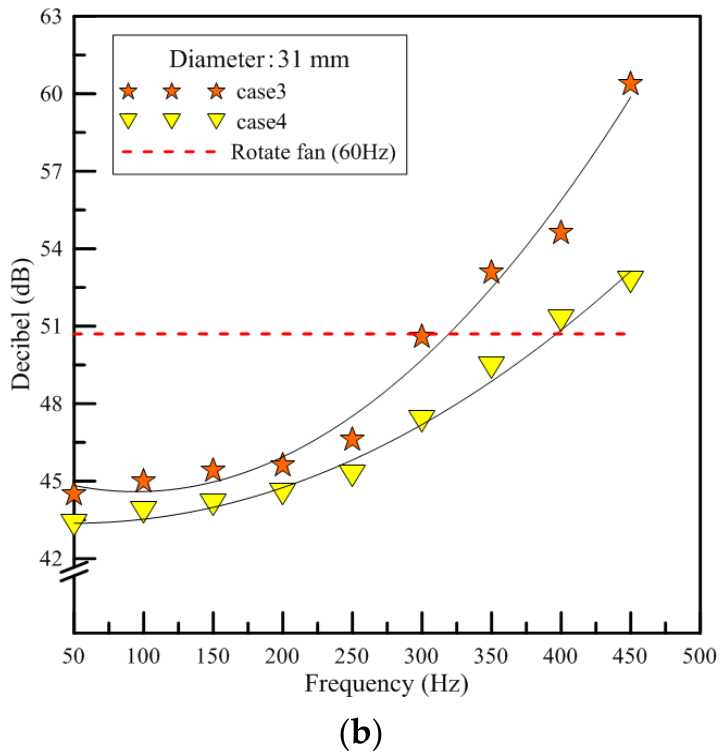
Figure 8. The results of noise measurement. ( a ) Case1, case2, case5 ( b ) Case3, case4